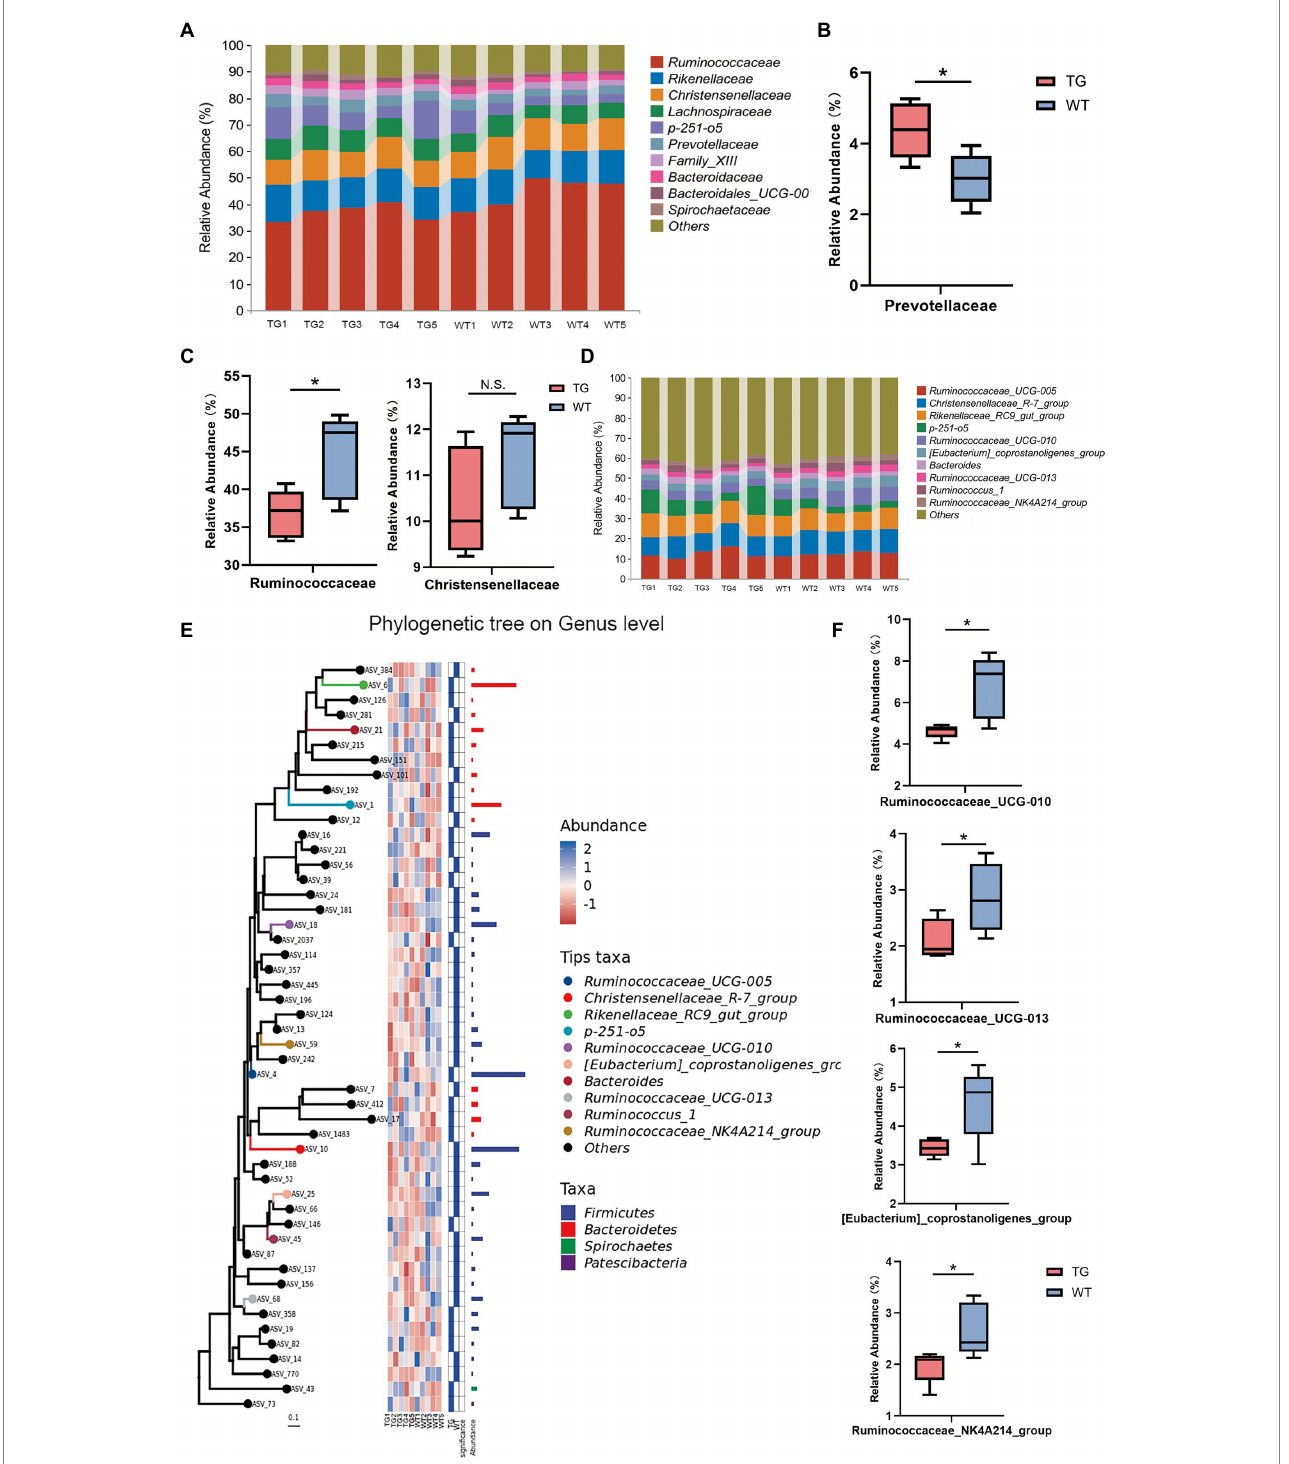
FIGURE 5 The impact of TLR4 overexpression on the composition of the intestinal microbiota in family and genus levels. (A) The relative abundance of fecal microbiota at the family level in all samples. (B) Relative abundances of Prevotellaceae. (C) Relative abundances of Ruminococcaceae and Christensenellaceae. (D) The relative abundance of fecal microbiota at the genus level. (E) Using phylogenetic tree to show evolutionary relationships of microorganisms at the genus level. (F) Box diagram of apparent changes in relative abundance at genus level. N = 5 each group. * p < 0.05 compared with the